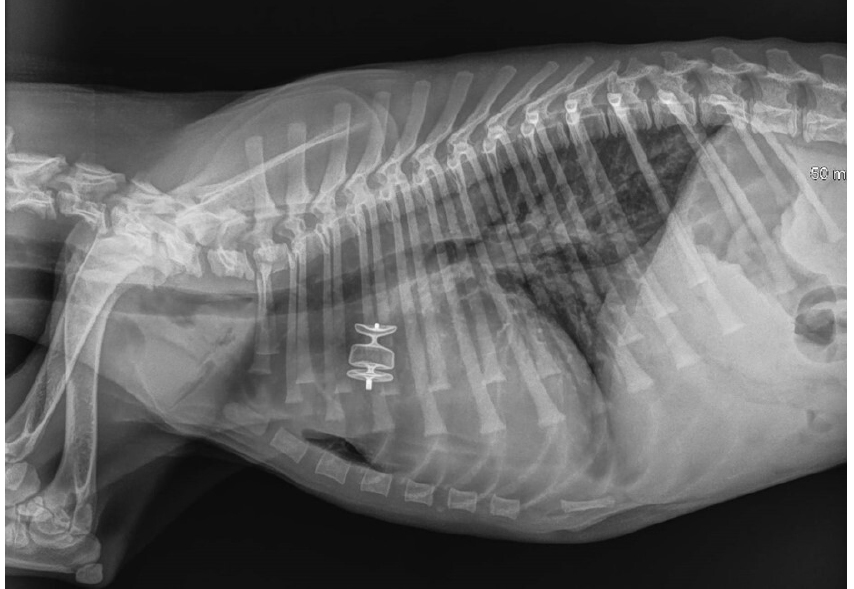
Figure 6. Immediate post-procedure right lateral thoracic radiograph (Case 3). The dog had pulmonary edema before the procedure, which was managed with medical treatment. The device is readily visible in situ. Mild pulmonary infiltrate was still observed in the lung field, especially the caudal lung lobes, after the procedure.